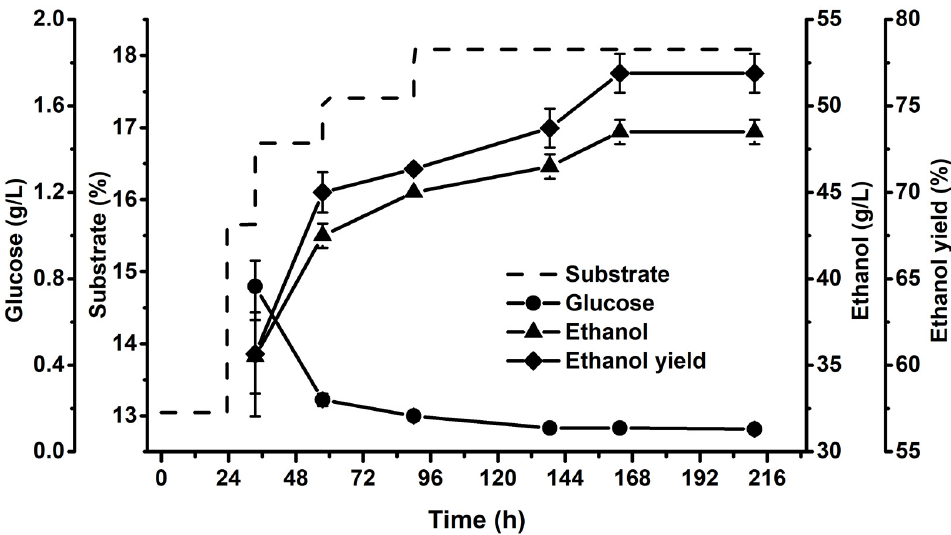
Figure 2. Changes in ethanol yield and concentrations of substrate, glucose, and ethanol during fed-batch S-SSF of DA-ASS-pretreated corn stover using Angel S. cerevisiae . Substrate: dotted line; Glucose: circle; Ethanol: triangle; Ethanol yield: rhombus.